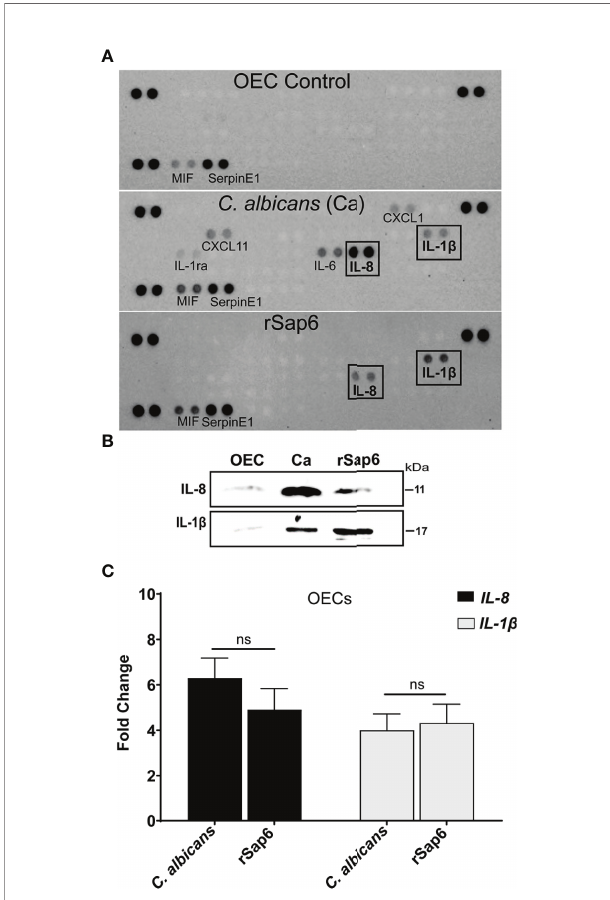
FIGURE 1 | Secreted aspartyl protease Sap6 induces IL-1 b and IL-8 in primary oral epithelial cells. (A) . Cytokine pro fi ling of OEC supernatant treated with Candida albicans (Ca) or recombinant Sap6 (rSap6) was examined using a proteome pro fi ler Cytokine Array Panel (A) Proin fl ammatory IL-1 b and IL-8 cytokines were detected in both Ca or Sap6 treated OECs although Ca induced release of additional cytokines in OECs. (B) OEC culture supernatants were collected following treatment with Sap6 or Ca for 24 h, then immunoblotted to con fi rmed secretion of IL-8 and IL-1 b . (C) Total RNA was isolated from OECs incubated with either Ca or Sap6 for 24 h, then expression levels of IL-8 and IL-1 b quantitated using RTqPCR using Il-8 and IL-1 b speci fi c primers with GAPDH as a housekeeping gene. There was no signi fi cant difference in expression levels of IL-8 or IL-1 b between OECs treated with Ca or Sap6. Experiments were performed at three independent time points in triplicate; and the mean ± SEM were analyzed using one-way ANOVA. ns, non signi fi